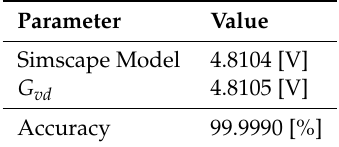
Table 4. Statistic mean of the output